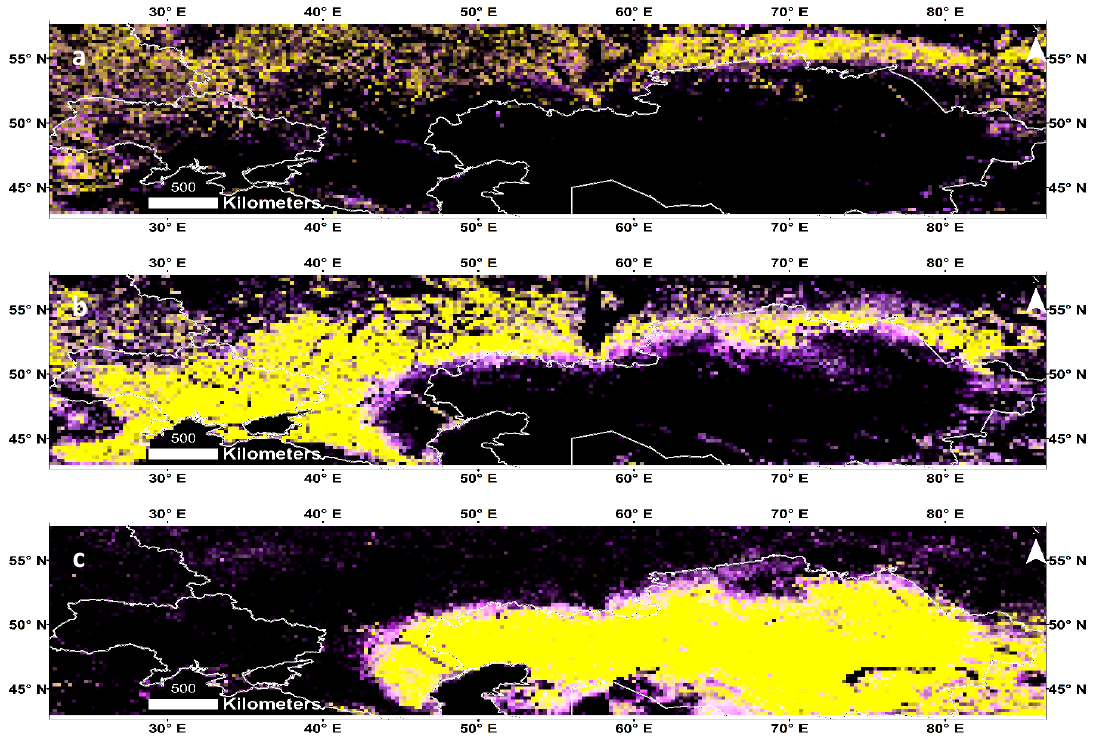
Figure 1. Land cover stability in Ukraine, southern Russia, and northern Kazakhstan as revealed by IGBP global land cover classification scheme MODIS 0.05° land cover products (resampled to AMSR-E spatial resolution: 0.25°) from 2003–2010: ( a ) crop–natural vegetation mosaic (IGBP class 14); ( b ) cropland (IGBP class 12); and ( c ) grassland (IGBP class 10). Land cover percentage from 2003–2010 displayed as red = maximum percentage, green = mean percentage, and blue = range of percentages. For legend, refer to Table 2.